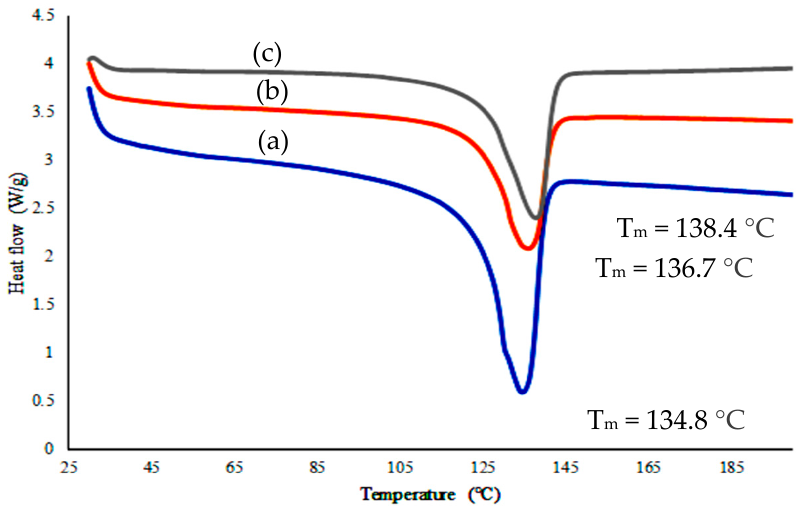
Figure 4. Different scanning calorimetry (DSC) curve of (a) HDPE (b) HDPE/30HAp and (c) HDPE/30HAp-S.